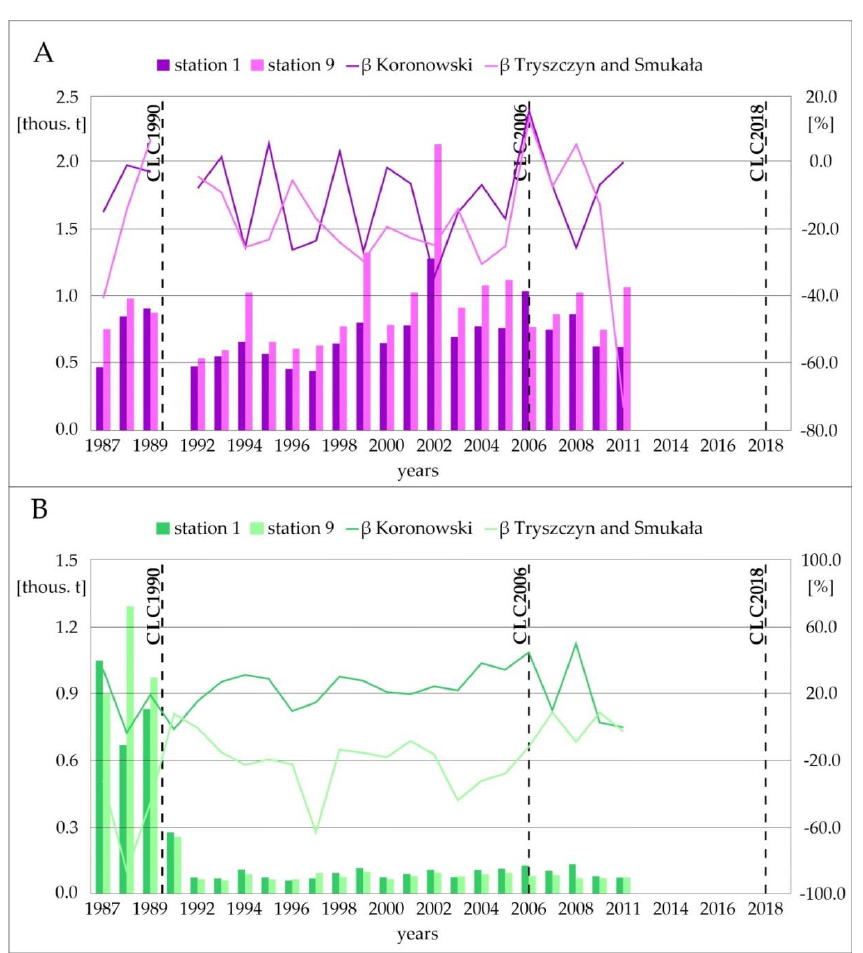
Figure 5. Changes in the inflow and outflow of nutrients total nitrogen load (TNL) ( A ) and